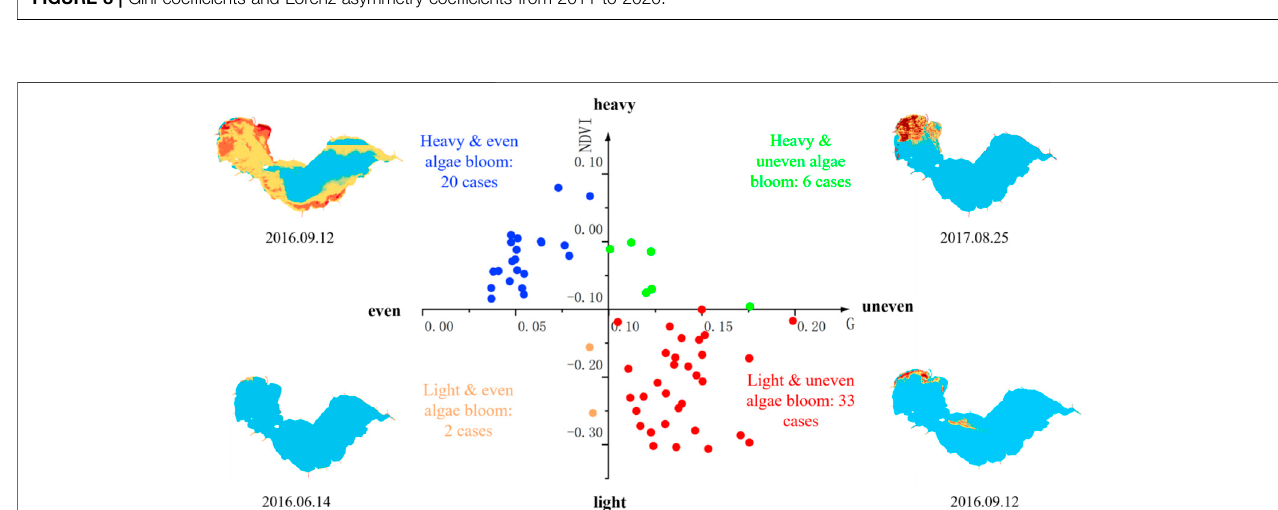
FIGURE 9 | Four types of algal bloom characterized by mean NDVI and G with example images.